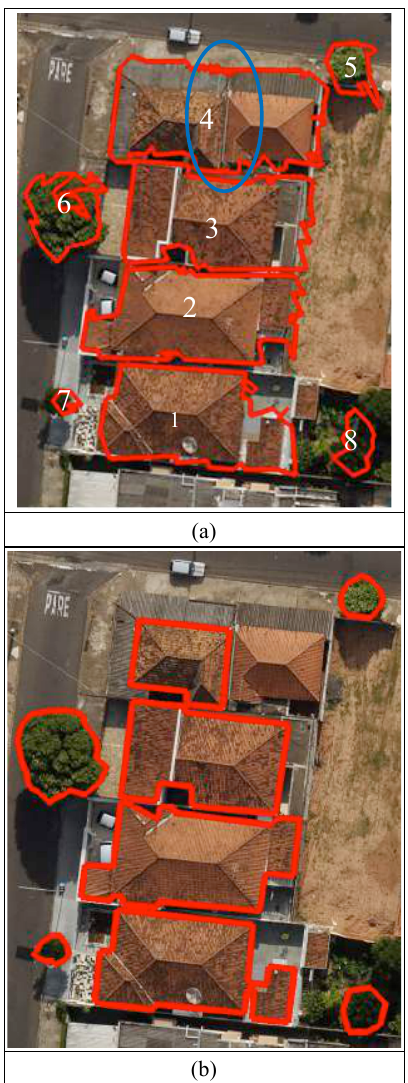
Figure 3. Test 2. (a) LiDAR-derived aboveground polylines projected onto the image; and (b) Polylines extracted from the